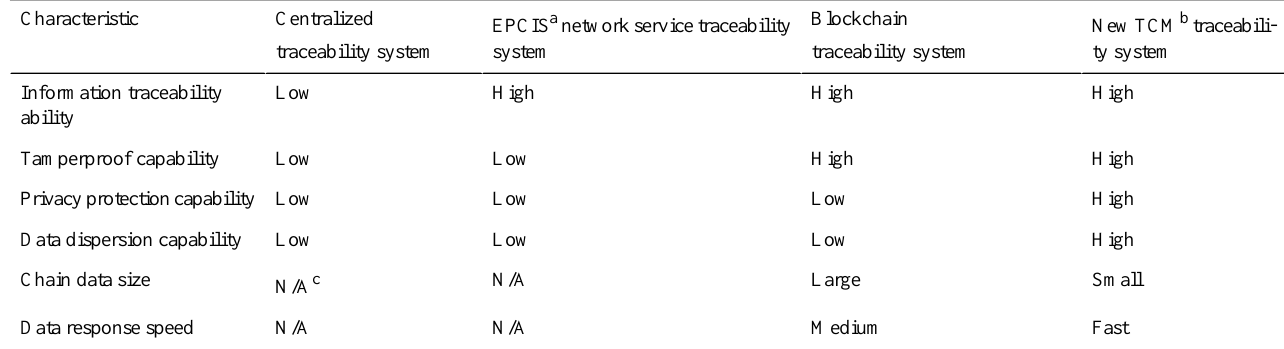
Table 1. Performance comparison chart of the new TCM traceability system and current mainstream traceability